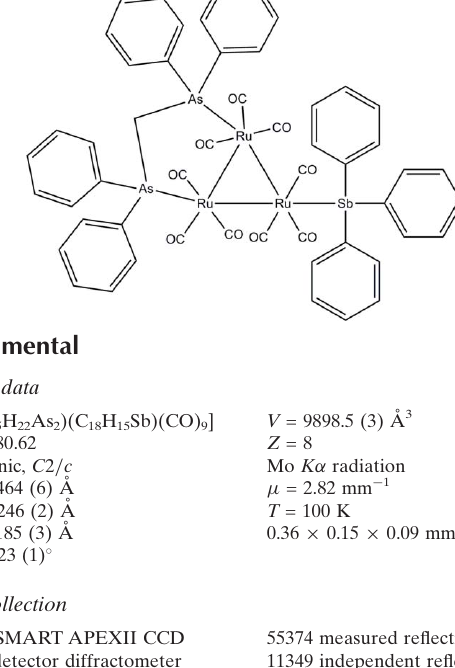
Data collection